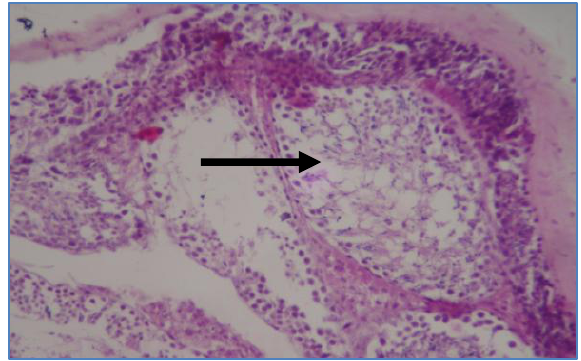
Figure, 1: Histological section in testis of mice given imipramine shows of unarrangement of seminiferous tubule with sloughing of its epithelial lining cells and loss of spermatid (H and Ex40).